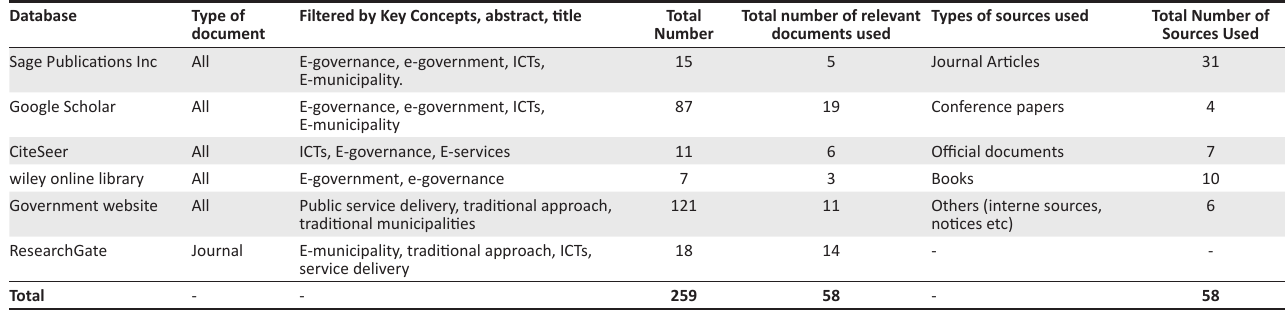
TABLE 1: Initial list of inclusion and exclusion criteria using all relevant sources, irrespective of years of publications. The inclusion criteria entail using any relevant document that unpacks the search topic and achieves the research aim.